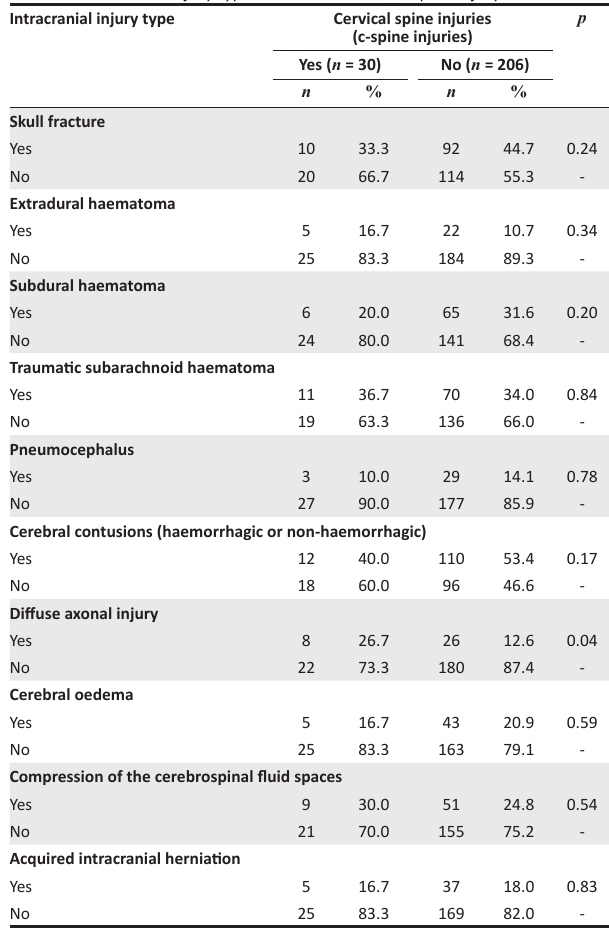
TABLE 3: Intracranial injury types associated with a c-spine injury. TABLE 1: Frequency distribution of age group, sex and level of consciousness